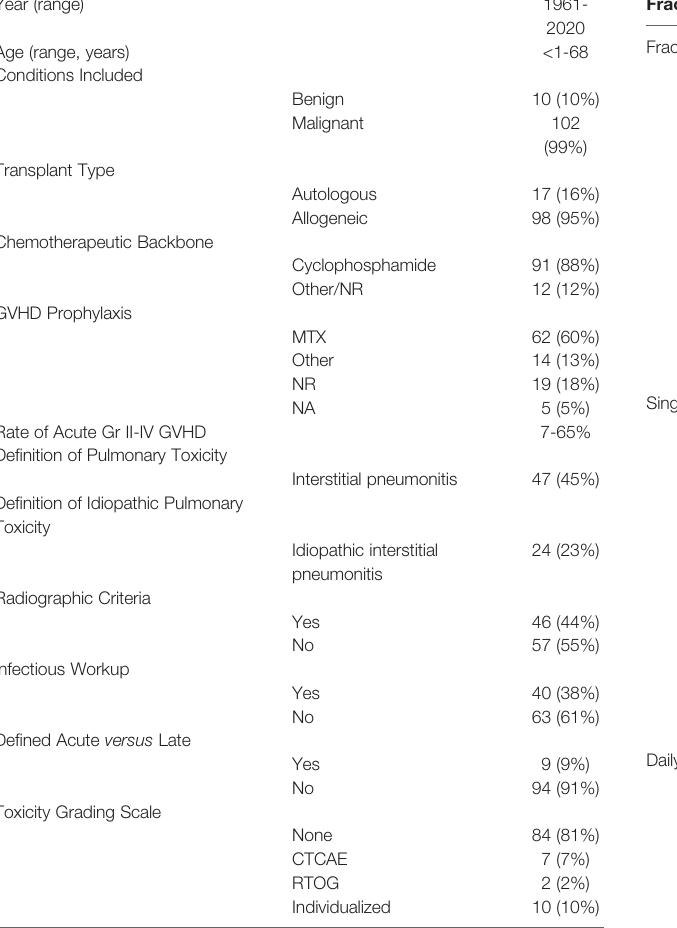
TABLE 2 | Study characteristics. TABLE 3 | Dose and